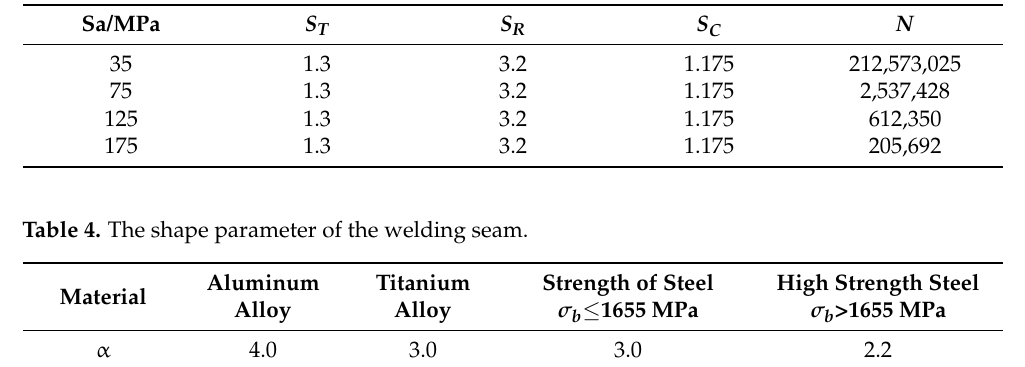
Table 3. The fatigue life test on the remanufactured 16Mn.